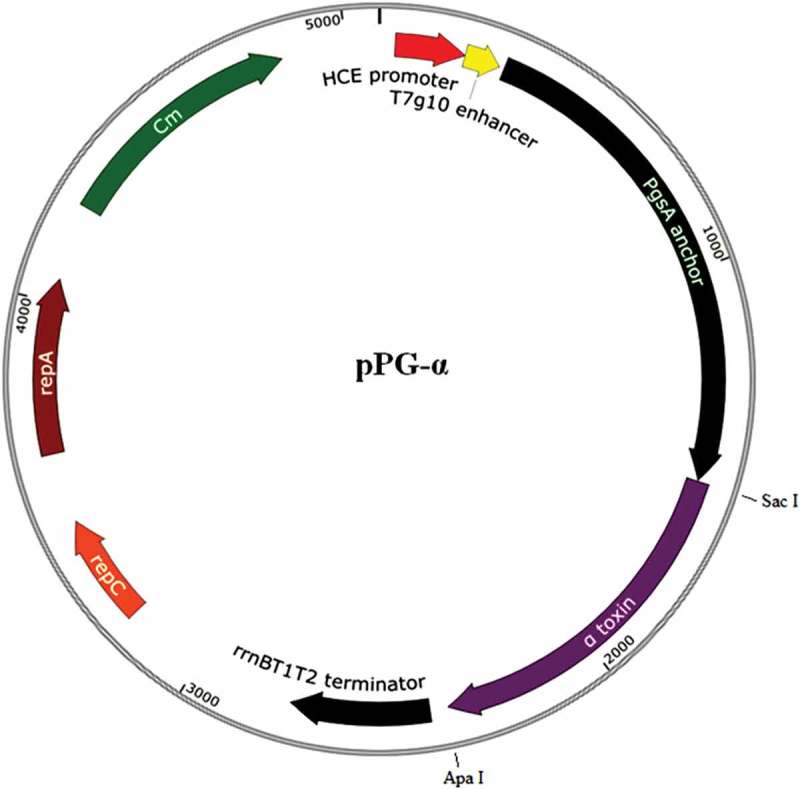
Recombinant plasmid pPG-α (containing the gene encoding the toxoid of C. perfringens α-toxin) constructed in this study. The gene fragment encoding the α-toxoid was obtained from plasmid pMD19-T-α constructed in our lab with Sac I and Apa I double-enzyme digestion and was inserted at the corresponding sites of pPG-T7g10, giving rise to pPG-α.